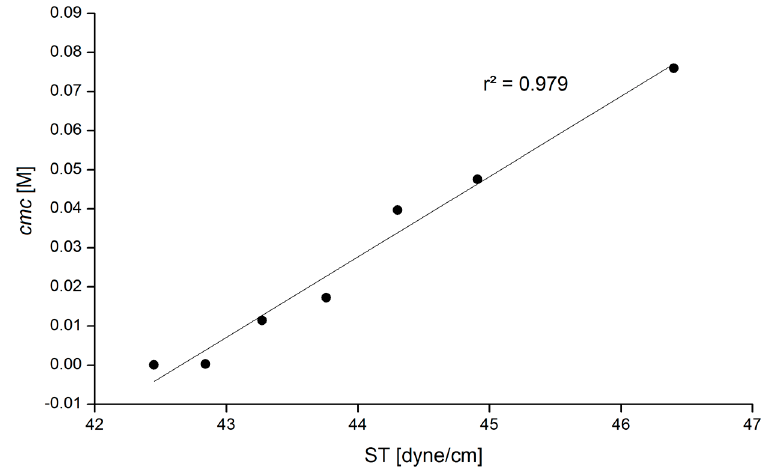
Figure 8. Dependence of cmc values on surface tension (ST [dyne/cm]) of whole compound.